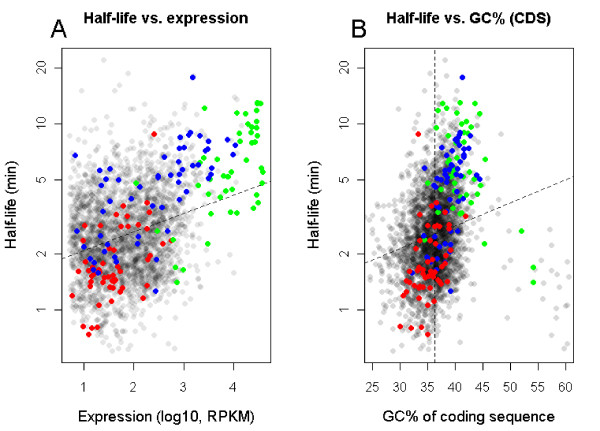
Statistical correlation between mRNA half-life and gene expression and G+C percentage of coding sequences. (a) Correlation between mRNA half-life and gene expression gene expression. (b) Correlation between mRNA half-life and G+C percentage of CDSs (the vertical dashed line marks the mean G+C%). In each panel, the dashed line represents the regression line. mRNA half-lives are plotted at log scale. Genes encoding ribosomal proteins (KEGG 03010) are represented by green dots, genes encoding proteins involved in glycolysis, gluconeogenesis and oxidative phosphorylation (KEGG 00010 and 00190) by blue dots, and genes encoding two component systems by red dots. The data shown are for B. cereus ATCC 10987.